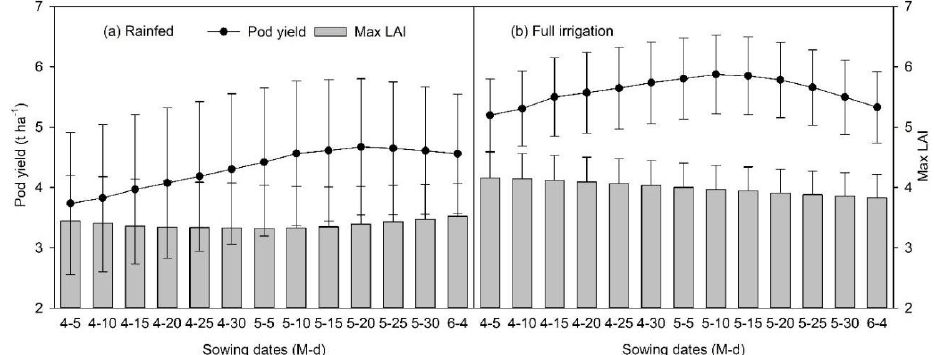
Figure 10. Simulated pod yield and maximum LAI of peanut of different sowing dates under rainfed ( a ) and full irrigation ( b ). Values are means of 304 data points.